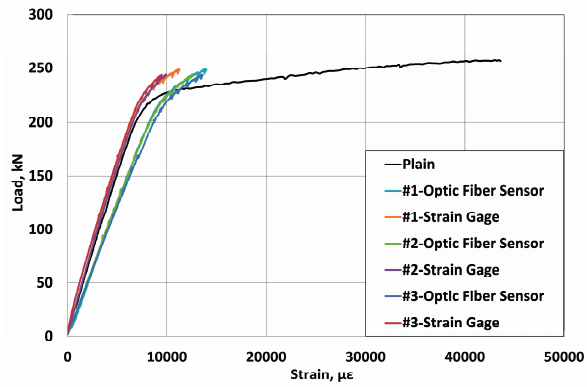
Figure 9. Load-strain curves of the sensing-strand (optical sensor & electrical strain